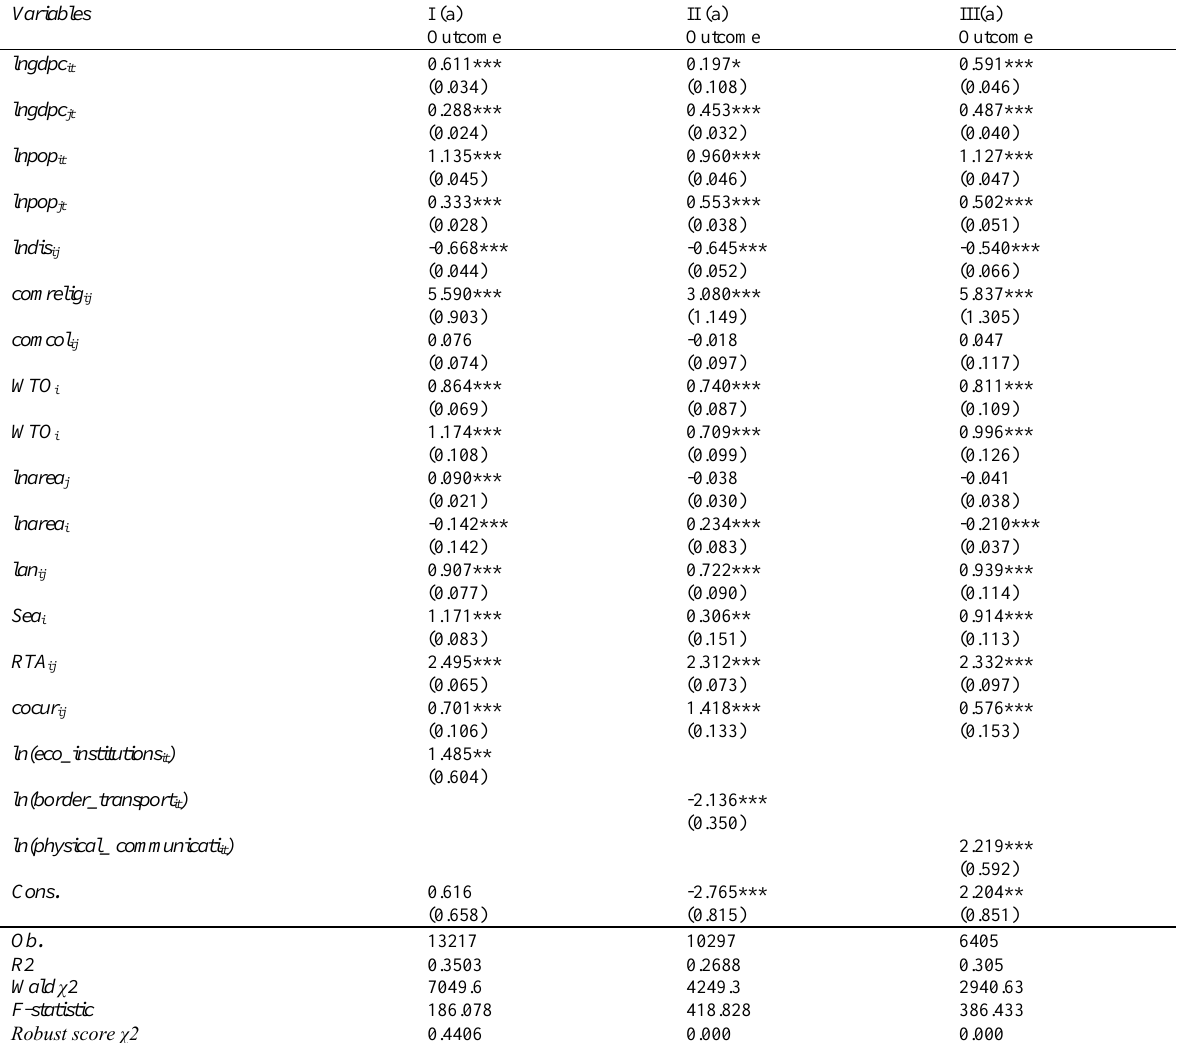
Table 4 : The effects of quality of economic institutions, border and transport efficiency, and physical and communication infrastructure on intra-Africa trade (IV